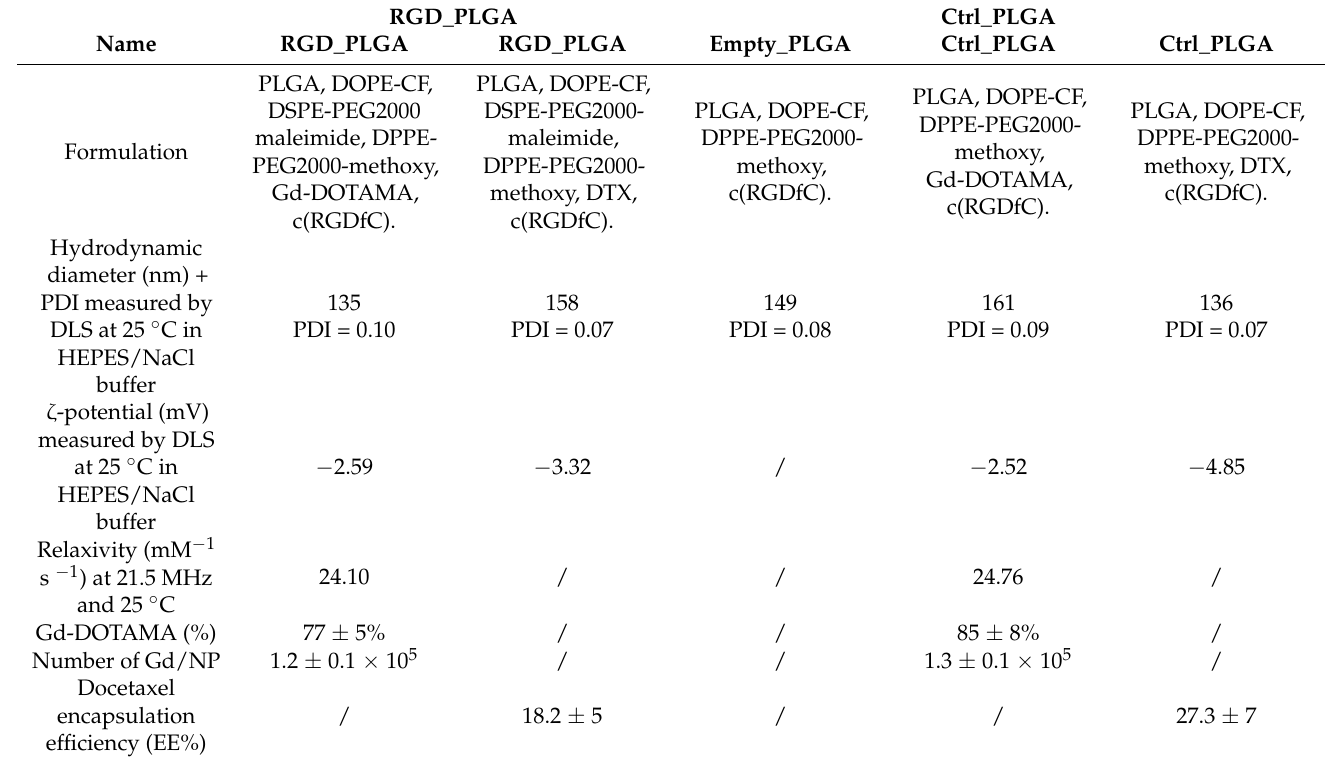
Table 1. PLGA-NPs employed in this